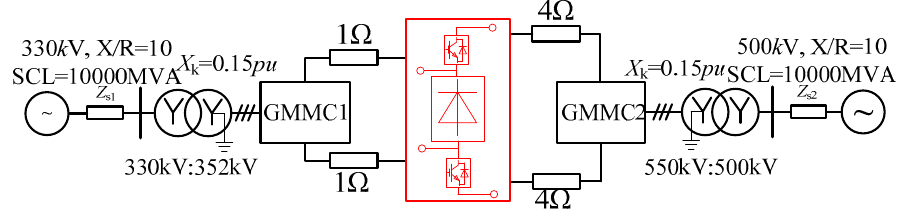
360 Table 2. Voltage and current ratings of the DCCB in the simulated UUDAT. Name V CBP ( V CBN ) I CBP ( I CBN ) P CBP ( P CBN ) Value 320 kV 1.5625 kA 1000 MW Table 3. Power and voltage ratings of MMC1, 3 in the simulated DUDAT. Ratings Basic Case 72 Table 5. Parameters of the AC transformers.